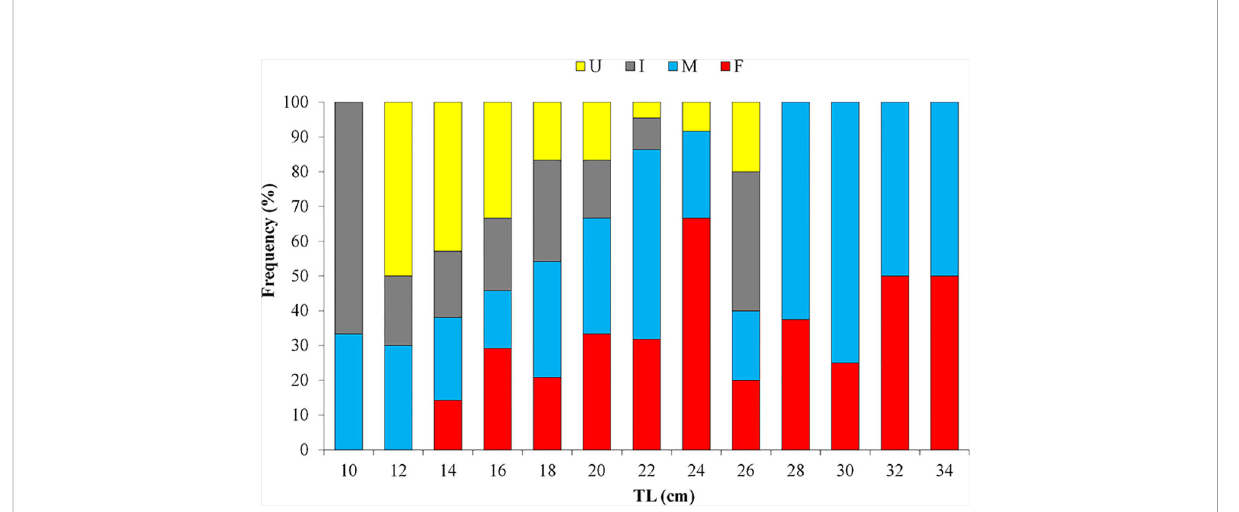
FIGURE 2 Length – frequency distribution in different size classes of female (F), male (M), undetermined sexes (I) and unsexed (U) specimens of Holothuria tubulosa